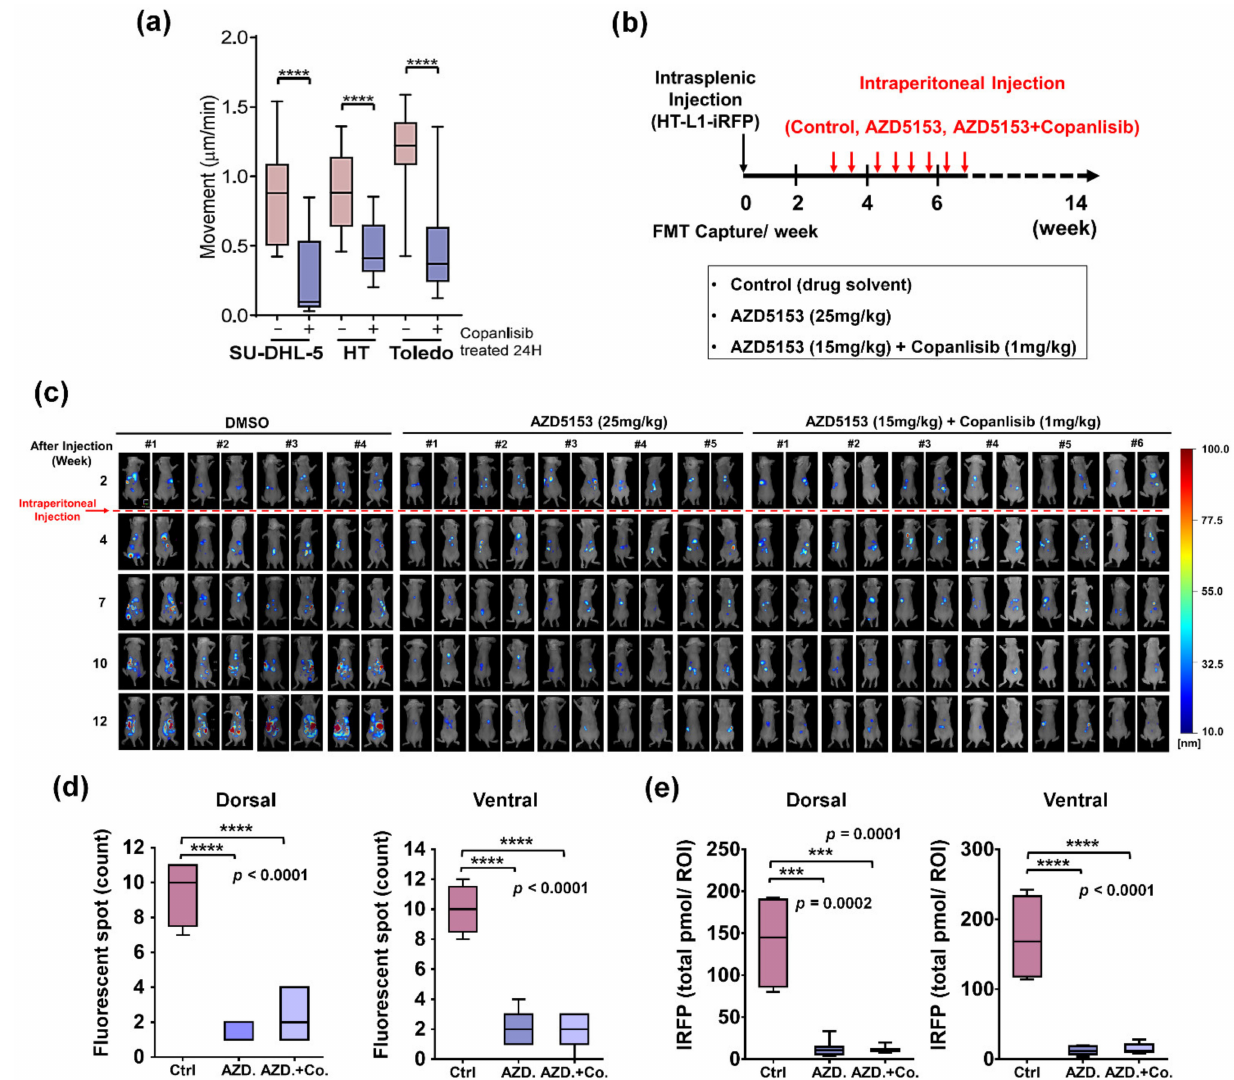
Figure 6. PI3K inhibitor attenuates the migration and dissemination of DLBCL. ( a ) Quantification of movement speeds of three DLBCL cell lines treated with copanlisib (0.5 µ M) ( n = 10). **** p < 0.0001, by Student’s t -test. ( b ) Schema for mice experiments. HT-L1-iRFP cells were injected into the spleens of 6-week-old SCID/beige mice. Intraperitoneal injection of drug solvent ( n = 8), AZD5153 (25 mg/kg) ( n = 8), or AZD5153 (15mg/kg) combined with copanlisib (1 mg/kg) ( n = 8) twice weekly was initiated at the end of week 3. ( c ) Detection of near infrared signals. The fluorescent signals in mice receiving different treatment were taken at the indicated time points. The time indicated here represents weeks after intrasplenic injection. ( d,e ) Enumeration of fluorescent tumor spots ( d ) and quantification of overall near infrared signals ( e ) in mice. Data collected through dorsal and ventral aspects of mice in Figure 6c are shown in box plots. Independent t -test was employed for statistical comparison. *** p < 0.001, **** p < 0.0001, by Student’s t